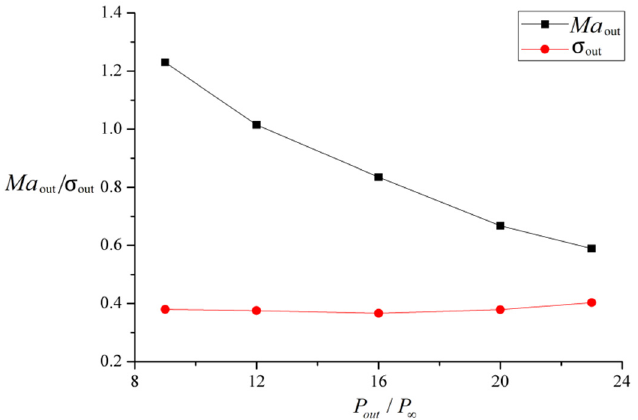
Figure 12. Variation of the outlet parameters with the back pressure ratio P out /P ∞ .